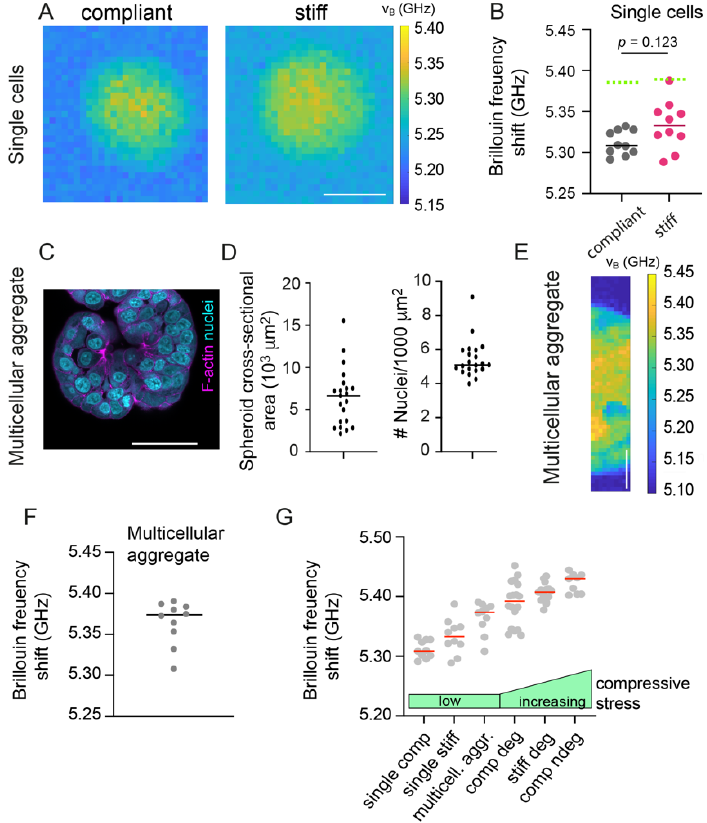
Figure 4. Brillouin frequency shifts increase with compressive stress. ( A ) Representative Brillouin maps of single MCF-7 cells grown in non-degradable compliant and stiff hydrogels at culture day 1. Scale bar corresponds to 10 µm. ( B ) Scatter plot showing corresponding Brillouin frequency shifts. n = 10. Solid lines indicate medians. Dotted green lines indicate medians of MCF-7 spheroids in non-degradable gels. A Mann–Whitney test was done for statistical analysis. p -values are given. ( C ) Representative confocal microscopy image of multicellular aggregates (not embedded within hydrogels) formed by MCF-7 cells 48 h after assembly. F-actin and nuclei were visualized using Phalloidin-TRITC and DAPI, respectively. Scale bar corresponds to 50 µm. ( D ) Cross-sectional area and number density of cells per unit area of multicellular MCF-7 aggregates. n = 20 spheroids. ( E ) Representative Brillouin map of multicellular aggregates as in C. ( F ) Scatter plot showing corresponding median Brillouin frequency shifts take from maps of multicellular aggregates as in E. n = 10. Line indicates median. Scale bar corresponds to 20 µm. ( G ) Median Brillouin frequency shifts obtained from a comparable set of experiments. For the different conditions, different levels of compressive stress level are expected as indicated by green bars, from single cells and free-floating multicellular aggregates to compliant and stiff degradable and non-degradable hydrogel cultures.